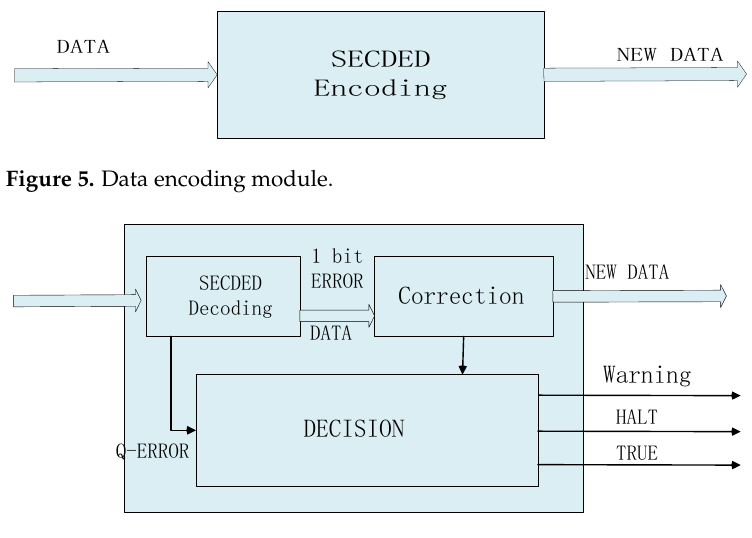
Figure 6. Embedded data decoding module. It is embedded in a combinational logic module to realize the SECDED decoding function and correct errors in time. It will generate an alarm signal in case of a multi-bit error.